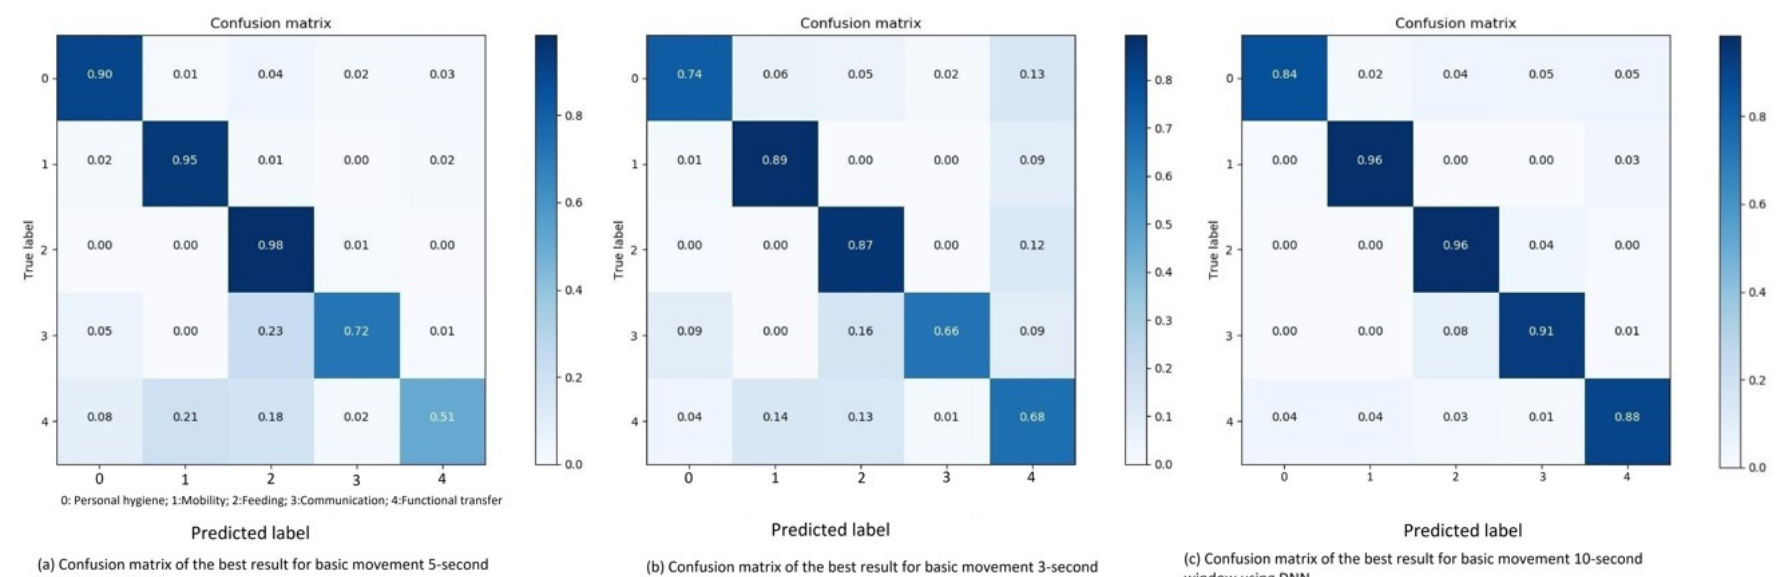
Figure 7. Confusion matrix of the best result for basic movement 3, 5 and 10-s window using